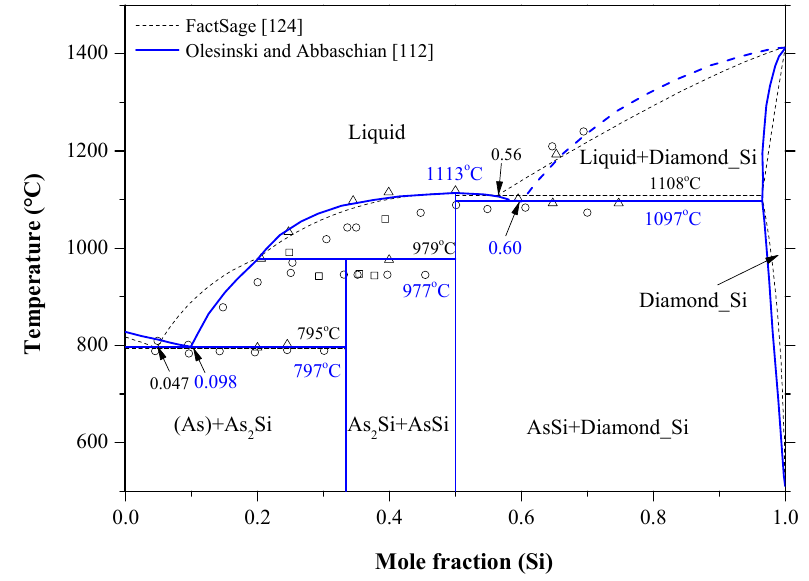
Figure 7. The As-Si phase diagram at ~40 bar [112]; ----: [124]; ○ : [113]; □ : [114]; Δ : [115].